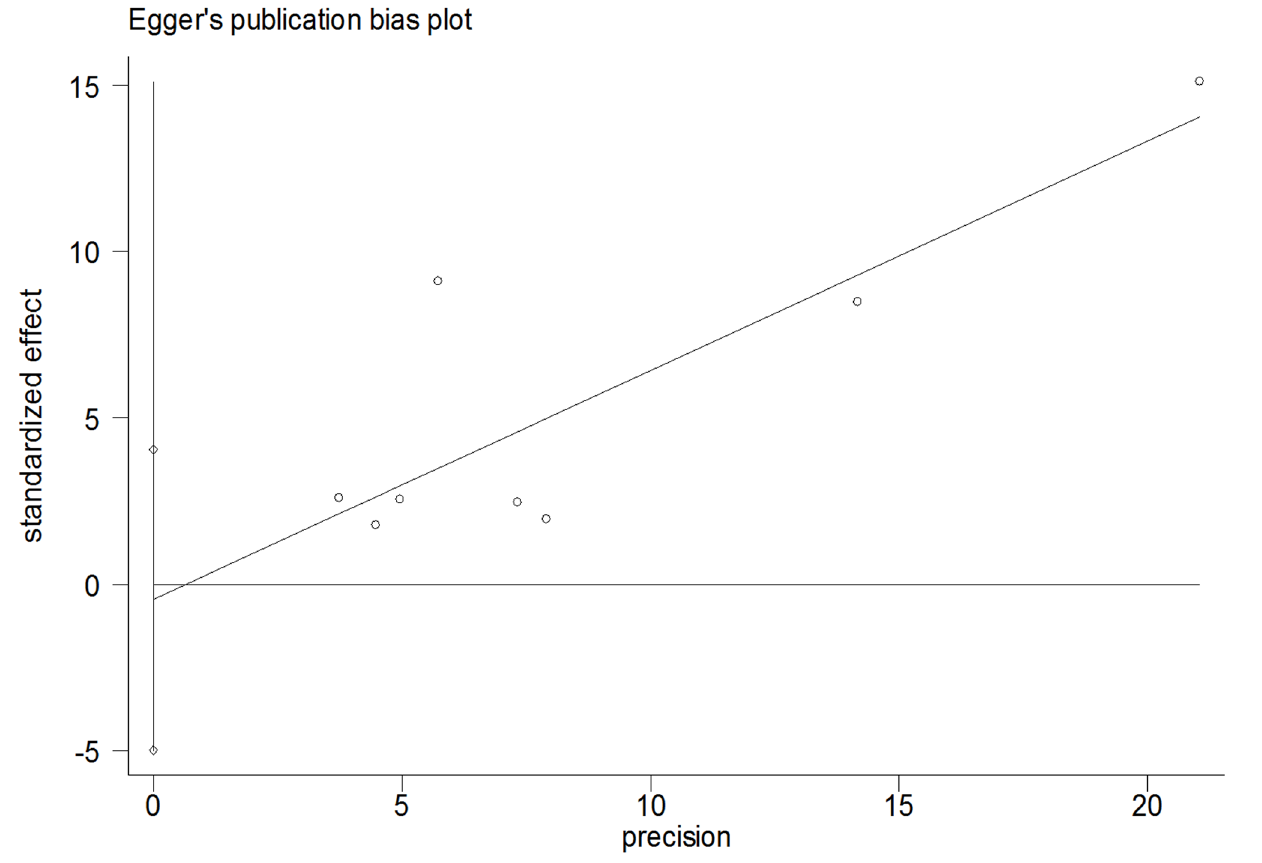
Fig 5. Egger ’ s Publication Bias